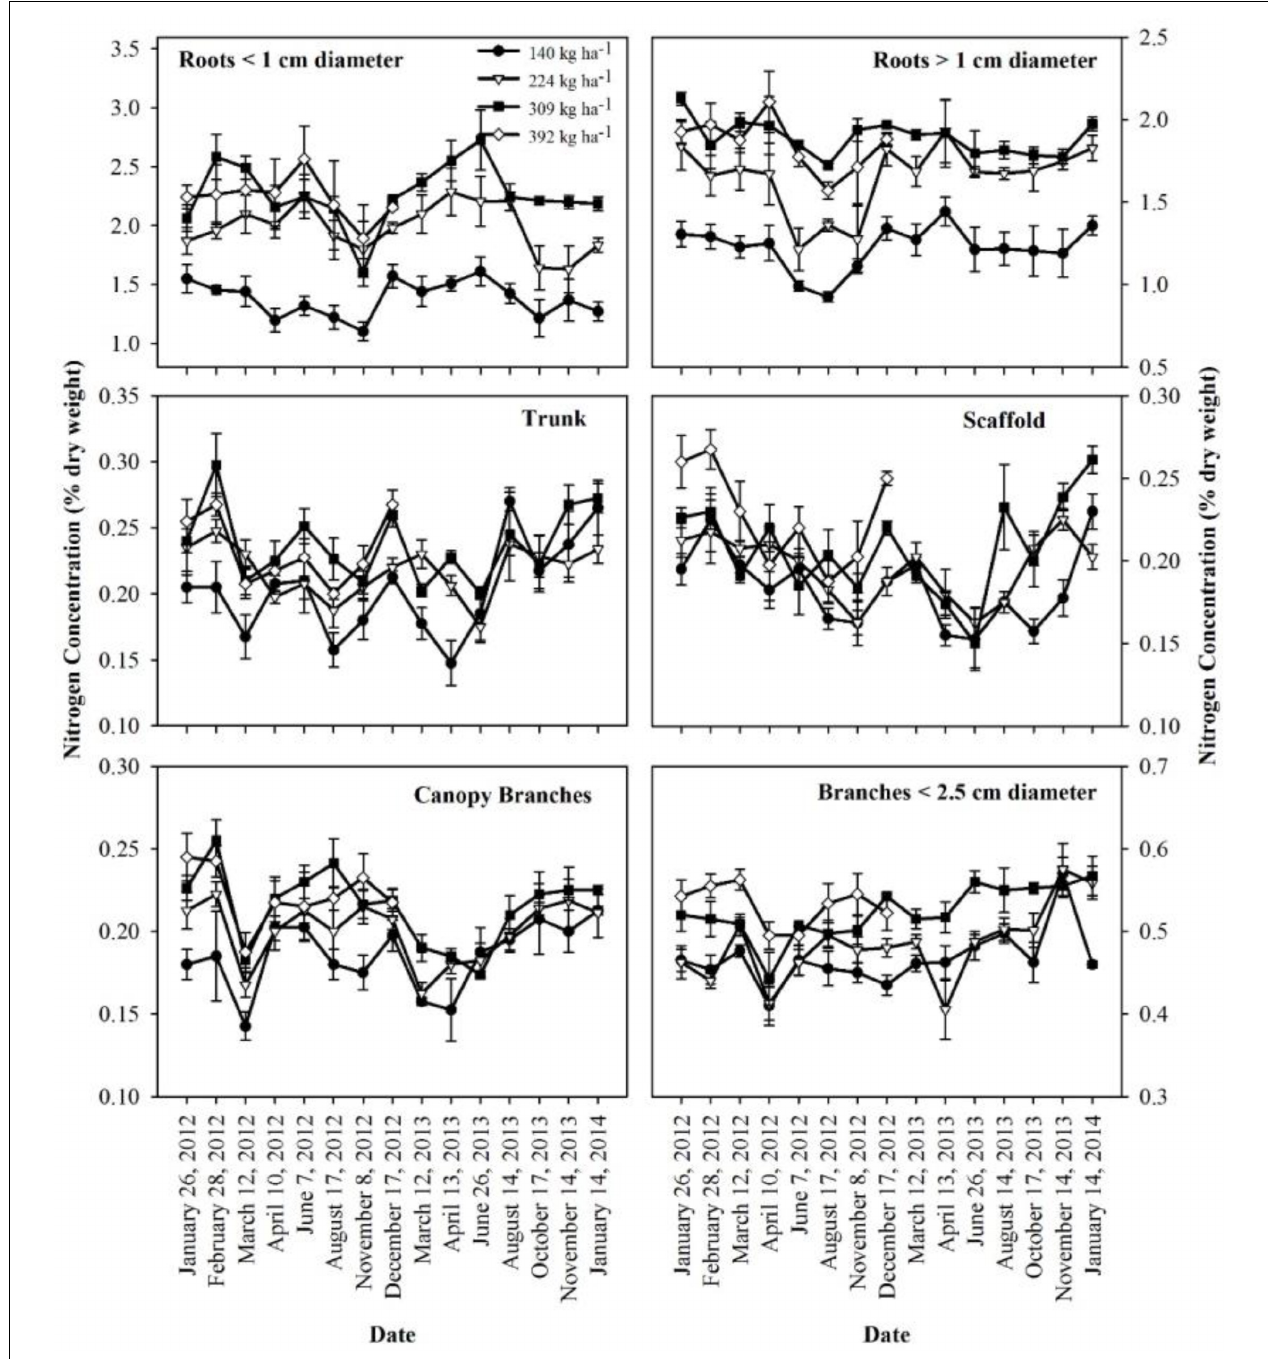
FIGURE 3 | Nitrogen concentrations in perennial tissues as affected by N application in 2012 and 2013 seasons. Data shows mean and standard error of the